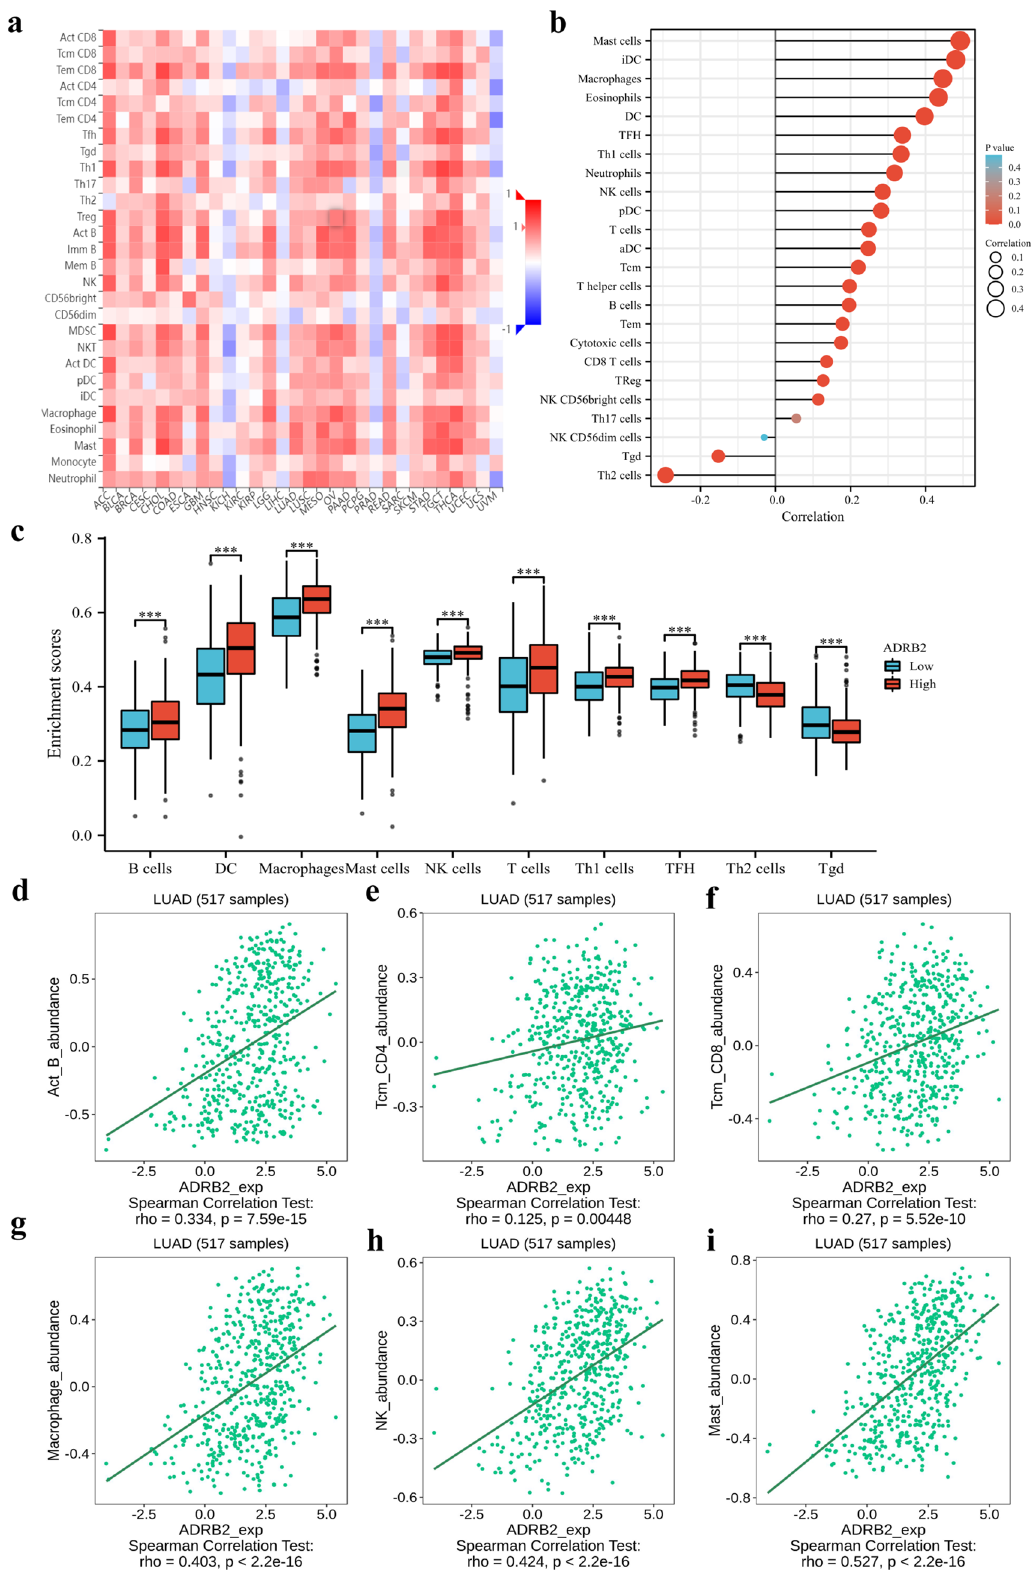
Figure 6. Relations between the expression of ADRB2 and 28 types of TILs across human cancers ( a ). The relationship between immune cell infiltration and ADRB2 expression ( b ). The infiltration levels of immune cell populations in lung adenocarcinoma (LUAD) patients with different ADRB2 expression ( c ). ADRB2 was correlated with abundance of B cells, CD4 T cells, CD8 T cells, macrophage, NK cells, and mast cells ( d – i ). *P < 0.05, **P < 0.01, ***P <